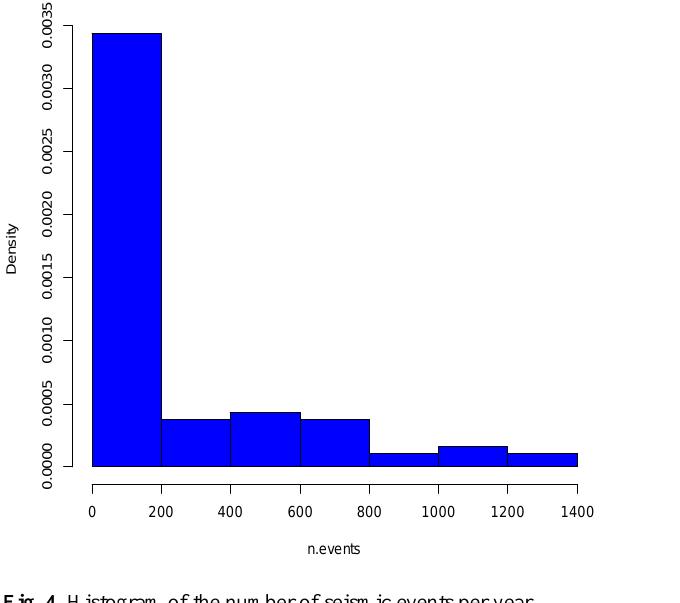
Fig. 4. Histogram of the number of seismic events per year. Figure 4. Histogram of the number of seismic events per year. 2